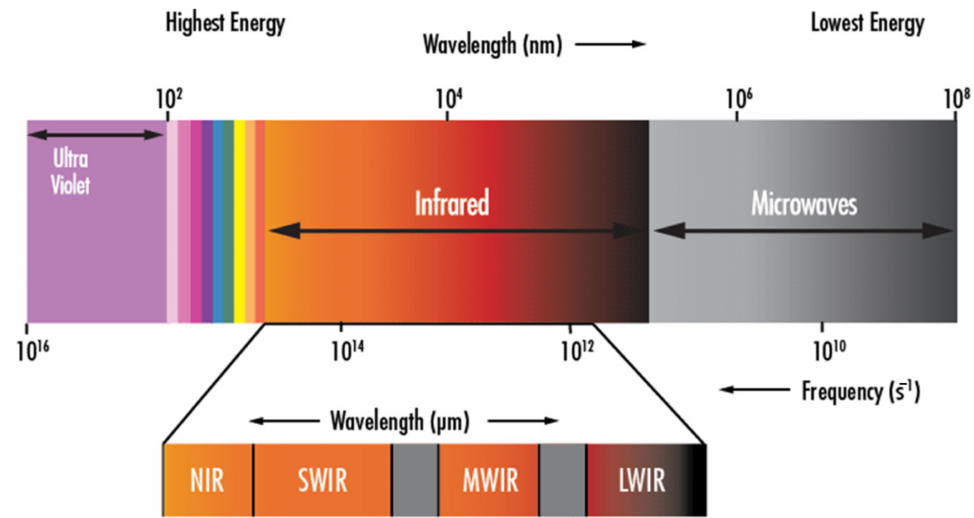
Figure 9. The range of the electromagnetic spectrum that can be covered by common optical tech- niques (digital, multi/hyperspectral, and thermographic cameras), as well as Gamma-ray, X-ray, microwave, and terahertz testing